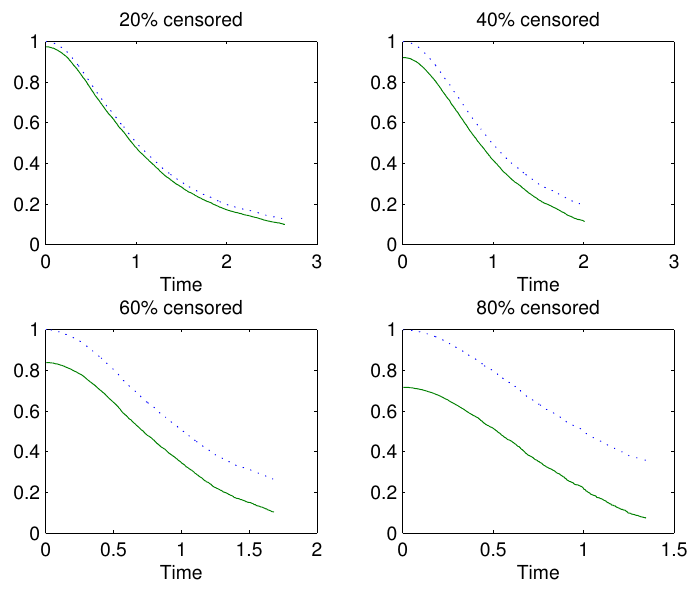
Figure 1. Weight comparison, W ( t ) (dotted) and W ∗ n ( t ) (solid) with ρ =